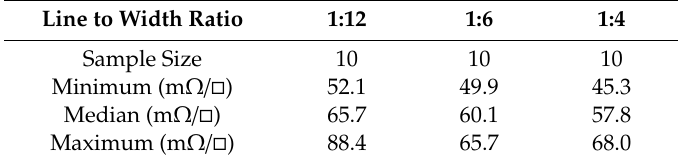
Table 4. Statistical key data of the sheet resistance measurement values for the type 7 substrate.